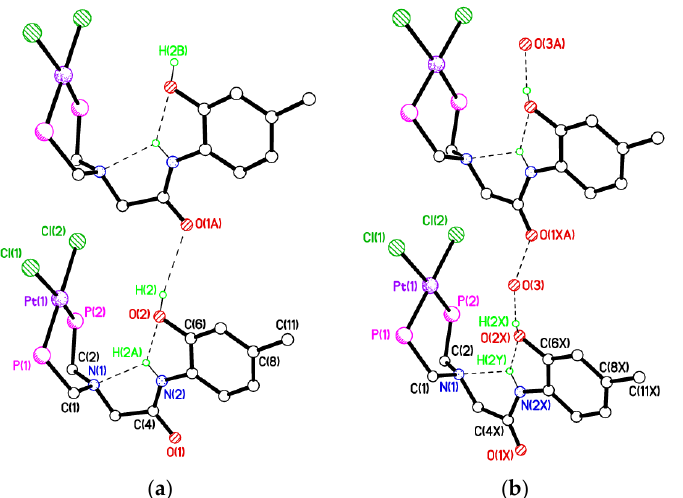
Figure 11. Most H atoms and 2 Ph groups per P atom have been omitted for clarity. ( a ) Packing motif 1 in the crystal structure of 5c . Symmetry operator A = x + 1, y, z. ( b ) Packing motif 2 in the crystal structure of 5c . The true structure is most likely an alternation of motifs 1 and 2. Symmetry operator A = x + 1, y, z.